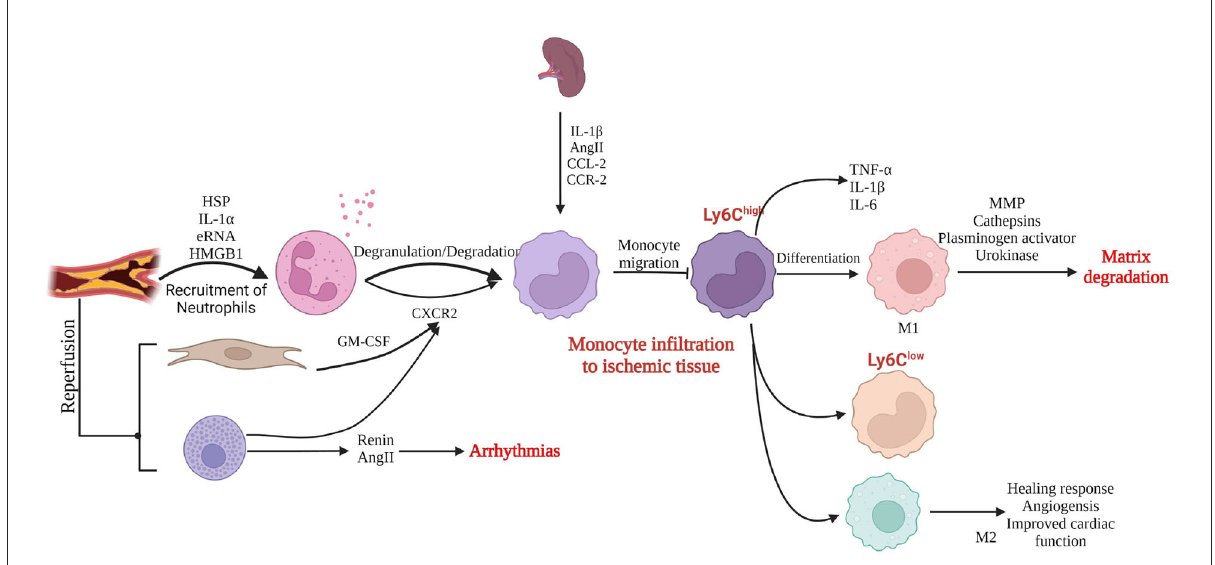
FIGURE10 Inflammatory response to myocardial injury (created with BioRender.com). HSP, heat shock protein; IL, interleukin, RNA, ribonucleic acid; HMGB1, high mobility group box 1; GM-CSF, granulocyte–macrophage colony-stimulating factor; AngII, angiotensin II; CXCR2, CXC chemokine receptor 2; CCL-2, C-C chemokine ligand 2; CCR-2, C-C chemokine receptor type 2; TNF, tumor necrosis factor; MMP, matrix